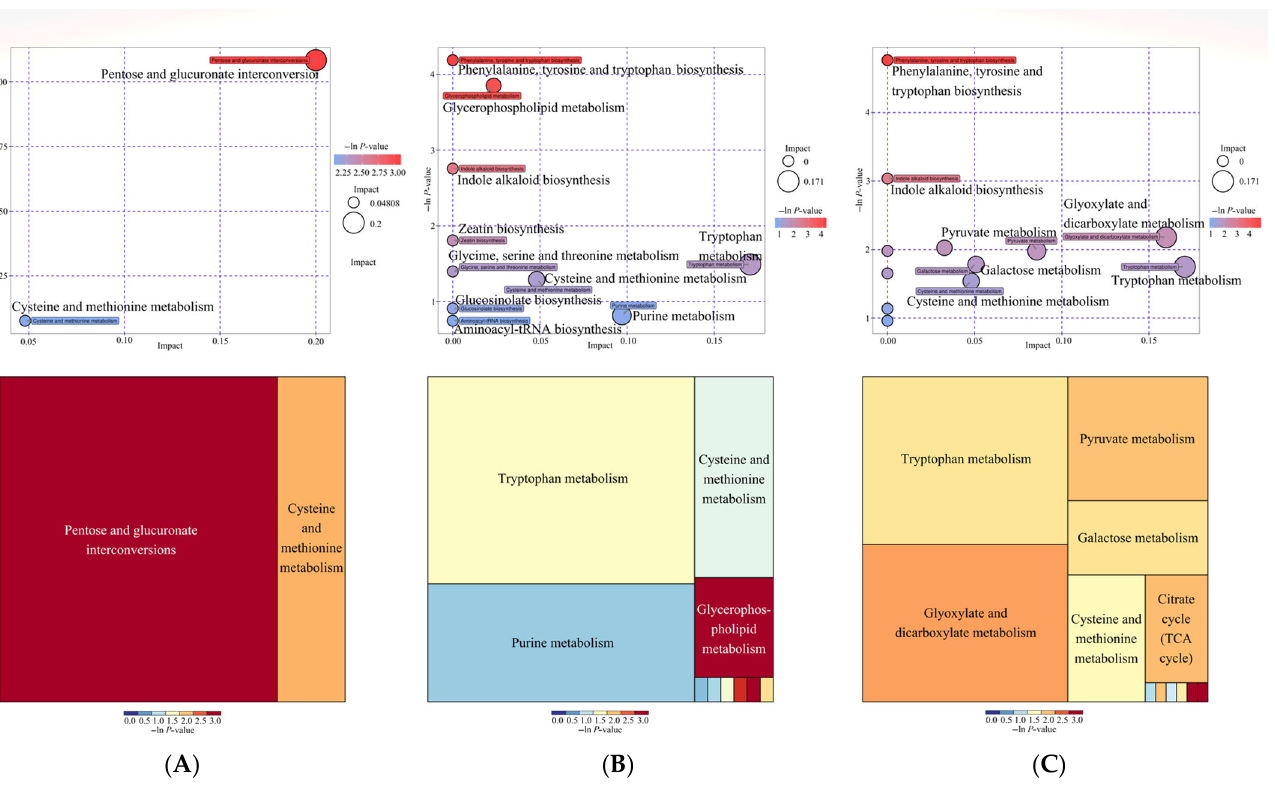
Figure 5. Bubble plots and tree plot of pathway analysis for the differential metabolites in group. ( A ) S1 vs. S2; ( B ) S1 vs. S3; ( C ) S1 vs. S4.